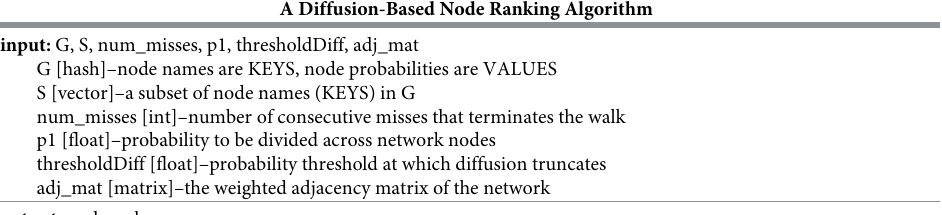
Table 3. A diffusion-based node ranking algorithm. A network walker uses a probability diffusion algorithm described in Table 2 to decide which nodes to visit in a network. Starting from a given node, snext , the network walker’s steps are recorded in vns (“visited nodes”). We record the network walker’s visited nodes, vns , for each starting node in S in a hash object, noderanks. A Diffusion-Based Node Ranking